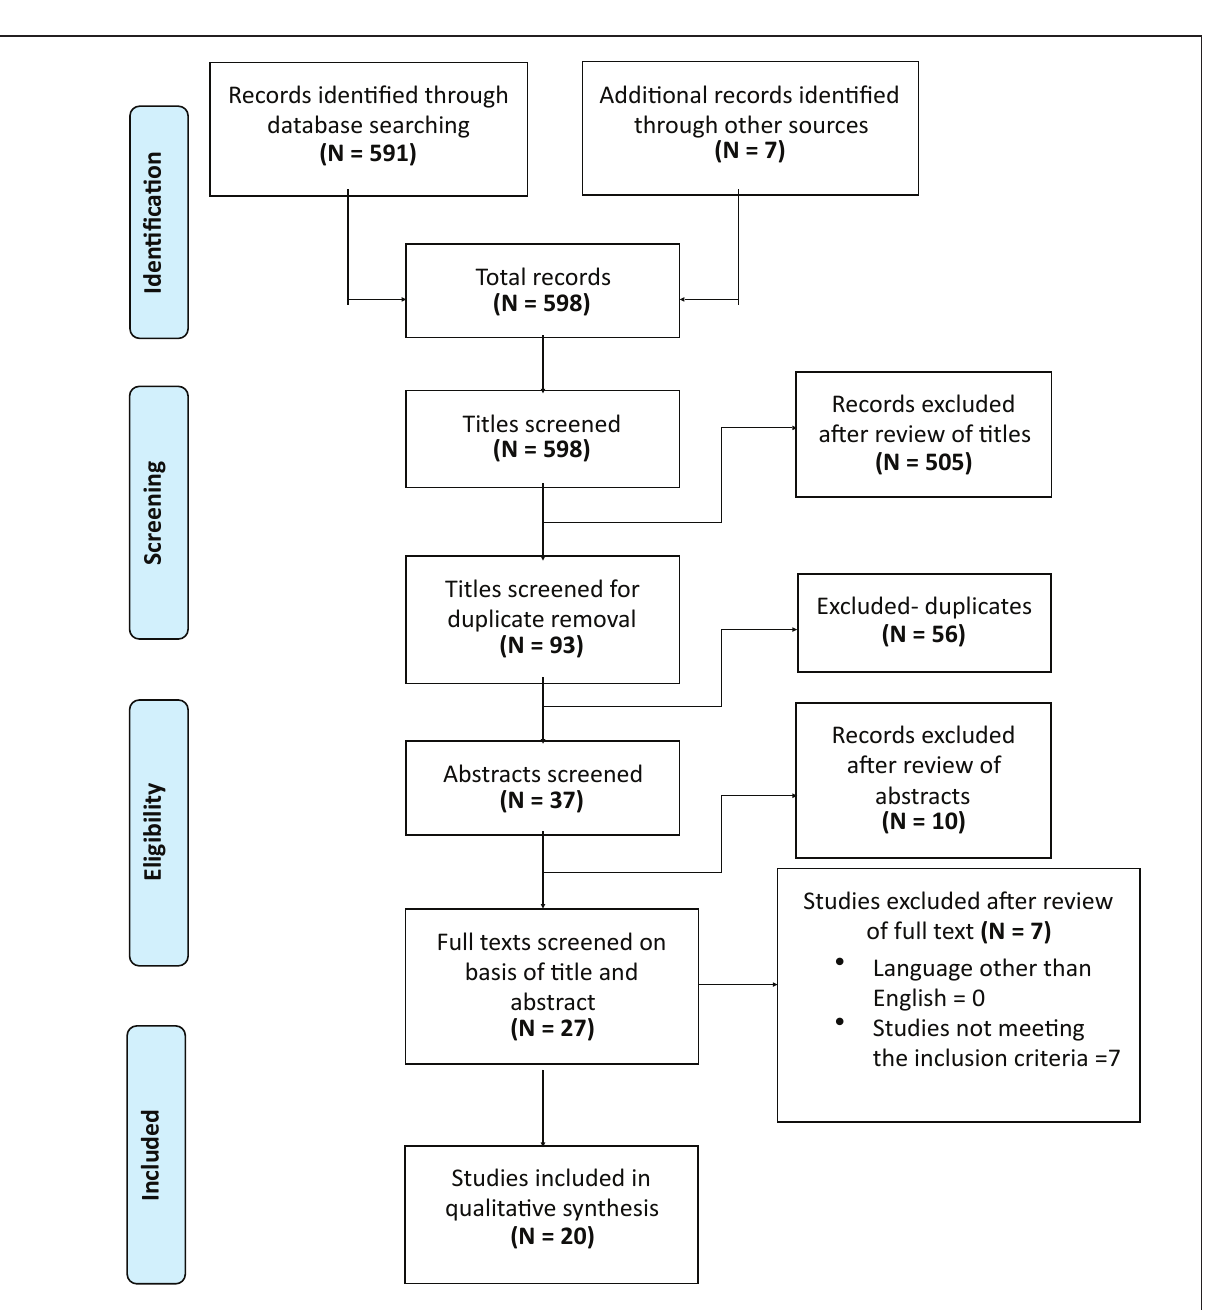
Figure 1. PRISMA 2009 Flow